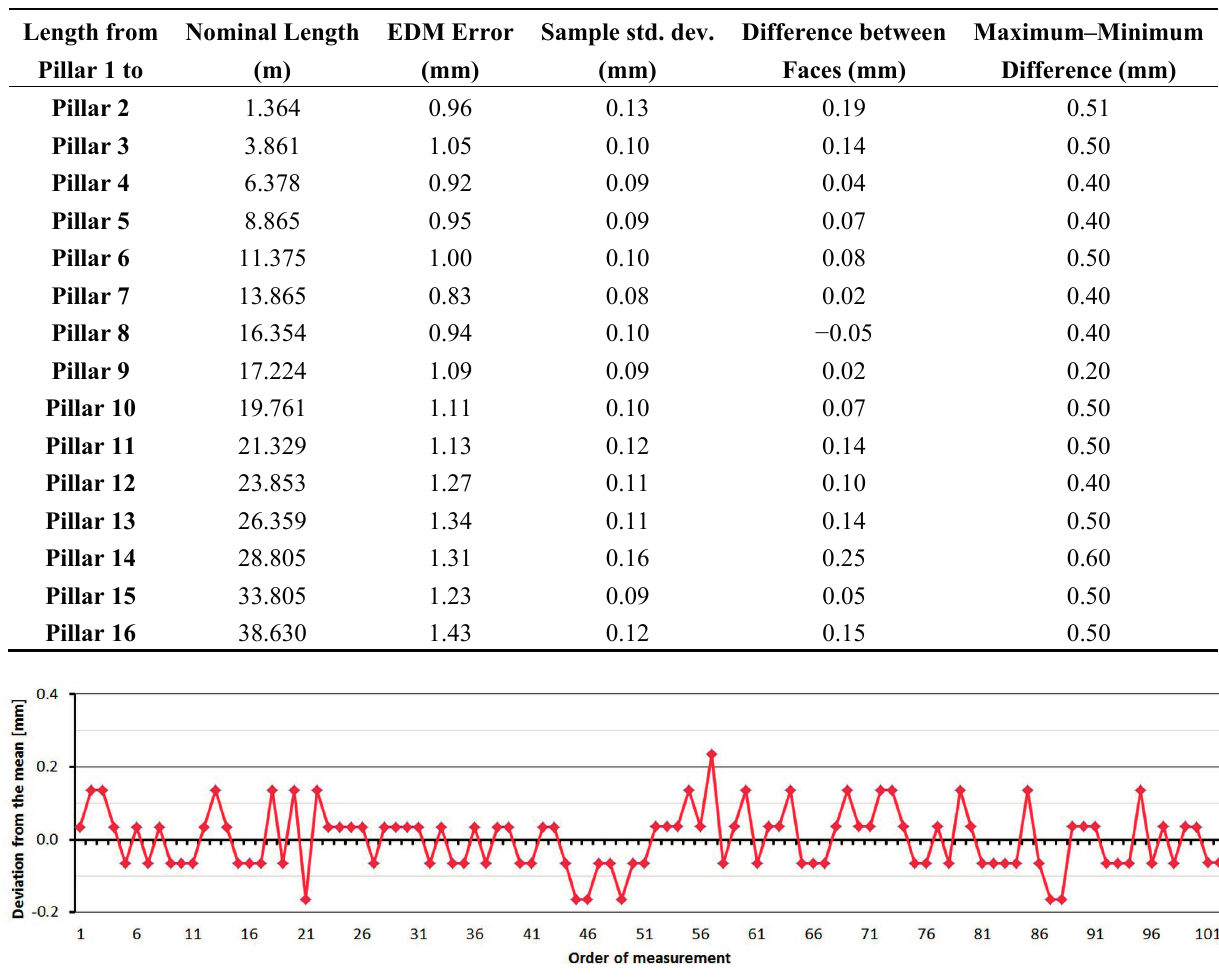
Figure 16. Leica TS06–Absolute errors in two epochs. Table 7. Leica TS06 (27 February 2014).